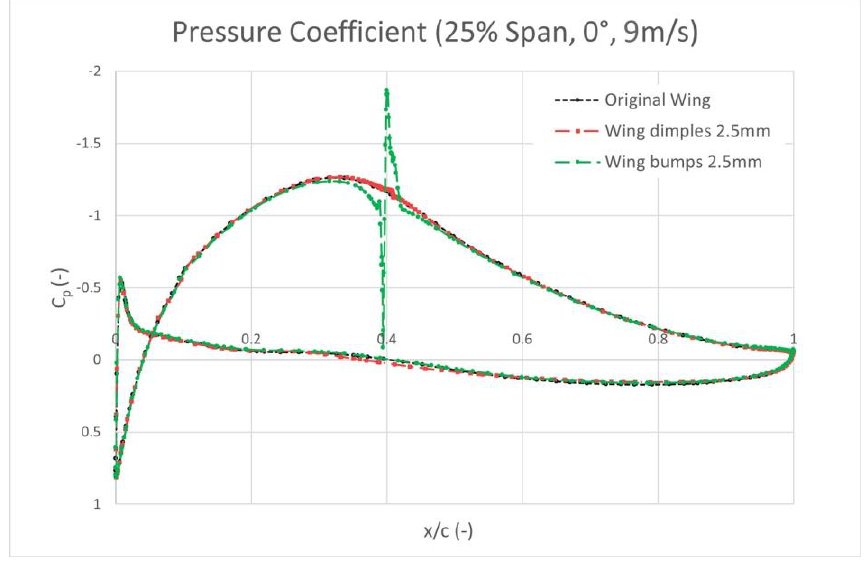
Figure 14. Pressure coefficient distribution around the airfoils at 25% of the wingspan at 0° AoA and Re = 86,000 of the three wings.